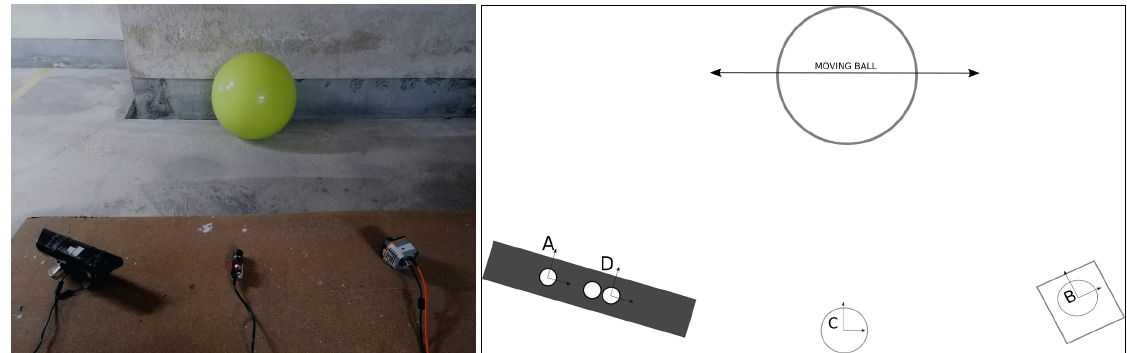
Figure 10. Example of set-up to collect data with the sensors placed in variate positions and orientations. A is the depth camera, B the IR camera, C the monochromatic camera, and D the RGB